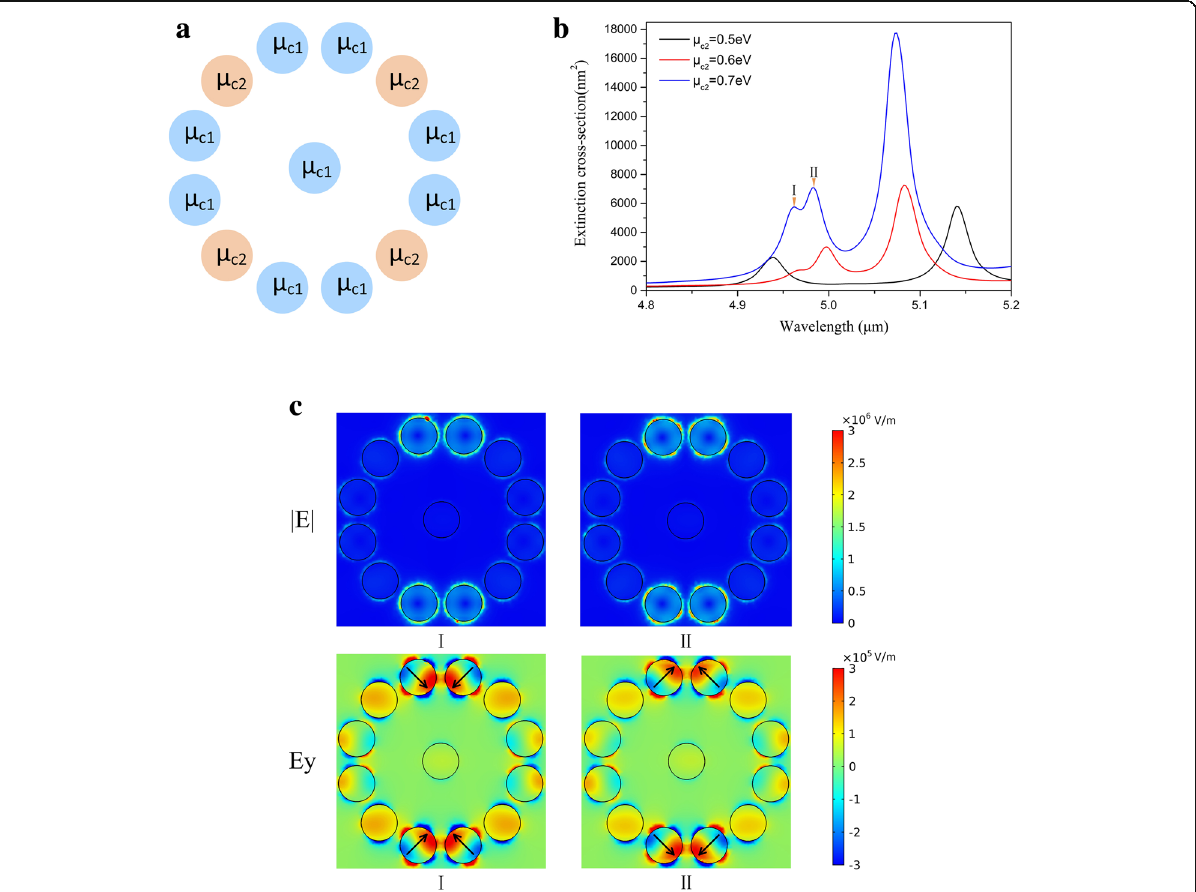
Fig. 4 a Schematic illustration of selectional graphene nanodisks with different chemical potentials to change chemical potential of intersection part. b The extinction spectra with increasing chemical potential of intersection part from 0.5 eV to 0.7 eV. c The electric fields (|E|) and the electric fields of y component (Ey) at the resonance peaks I and